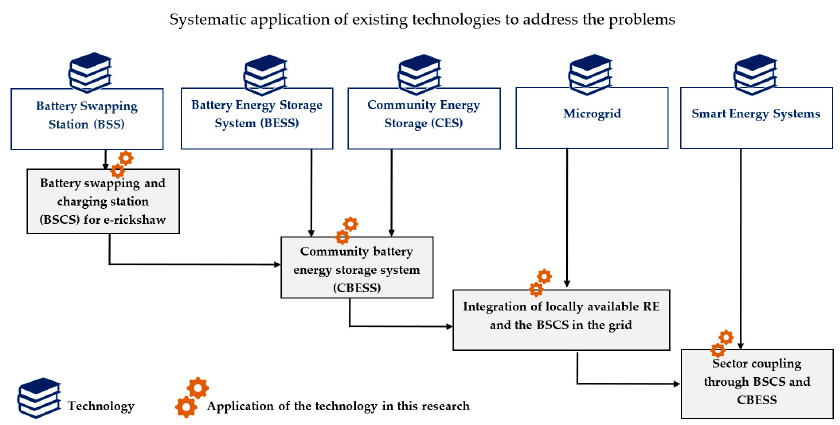
Figure 4. Application of existing technologies in this research to address the problems. Table 1. Stackable technologies, their applications, and implications for e-rickshaws and RE promotion.